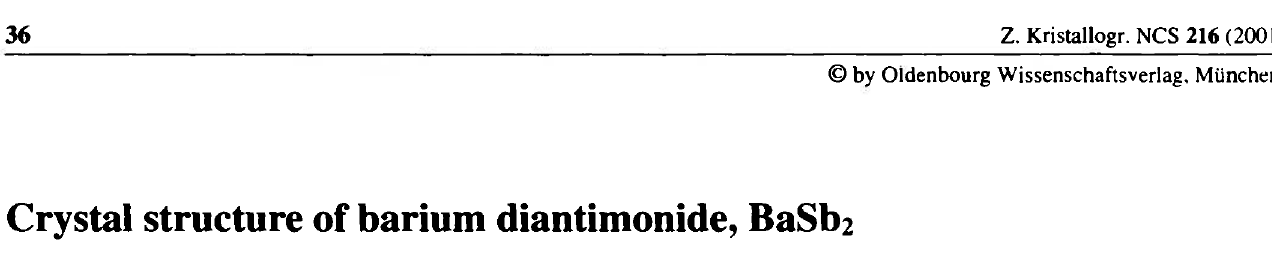
Discussion BaSt>2 crystallizes in the CaSb2 structure type [ 1 ] and completes the series of alkaline earth diantimonides. The structure is charac- terized by planar zigzag chains [Sb - ] which are separated by Ba 2+